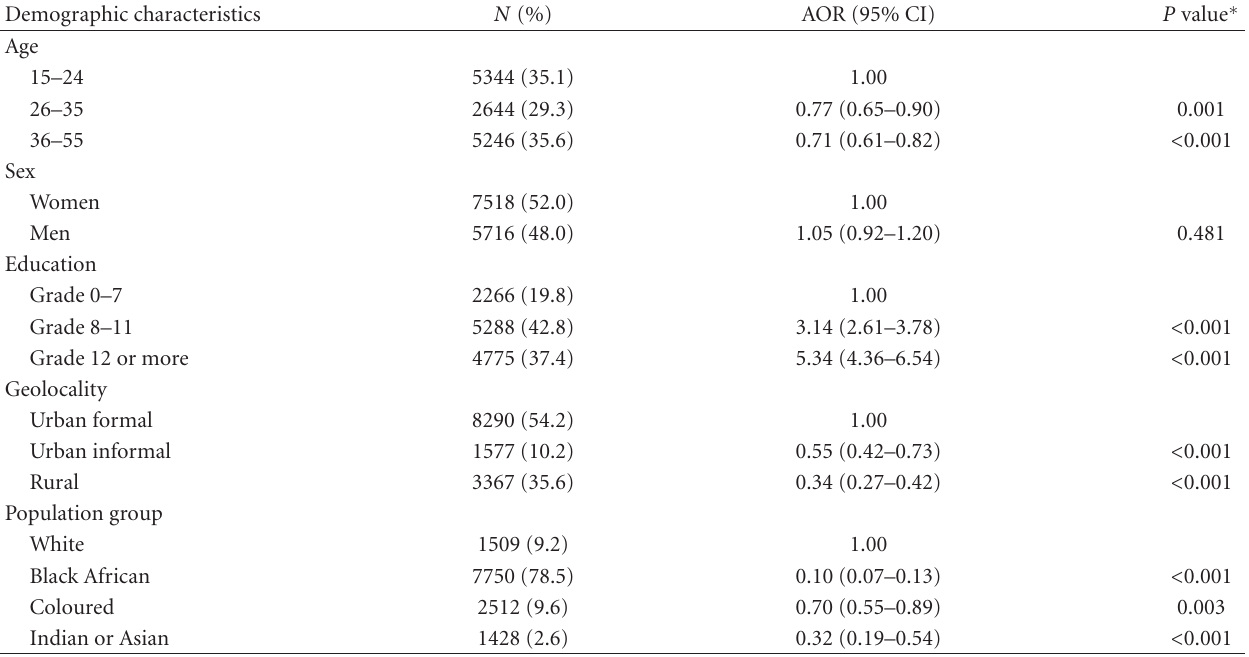
Table 3: Association of demographic characteristics and overall exposure to HIV communication campaigns ( N = 13234). Demographic